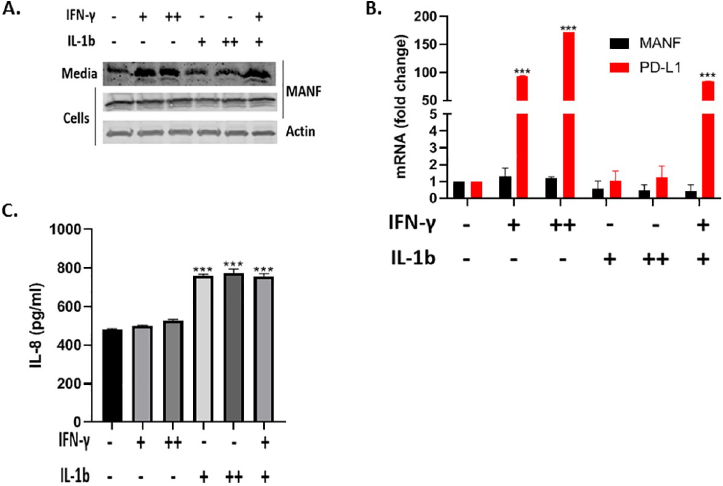
Fig 3. IL1B did not induce MANF secretion in SKMEL28. SKMEL28 cells were treated with 50 ng/ml (+) or 100 ng/ ml (++) IFN- γ and 5 ng/ml (+) or 20 ng/ml (++) IL1B for 48 hours, followed by immunoblot analysis of the cells and media (a), RT-PCR analysis of MANF and PD-L1 (b), and IL-8 ELISA analysis of the media (c). RNA expression is relative to baseline. N = 3, data is represented as mean ± SEM. ��� p-value < 0.001.